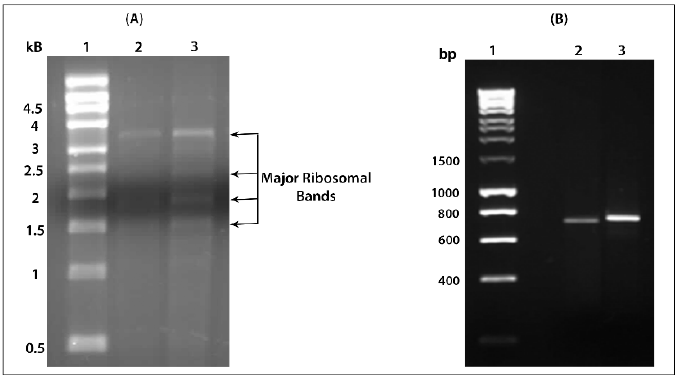
Figure 3. ( A ) Formaldehyde electrophoreses gel (1%). Lane 1: RNA size marker; Lane 2 and 3: two different total RNA samples from mistletoe leaves. ( B ) Agarose gel (1%) showing amplified chain A and chain B of mistletoe lectin. Lane 1: HyperLadder I; Lane 2: amplified chain A (MLA); Lane 3: amplified chain B (MLB).